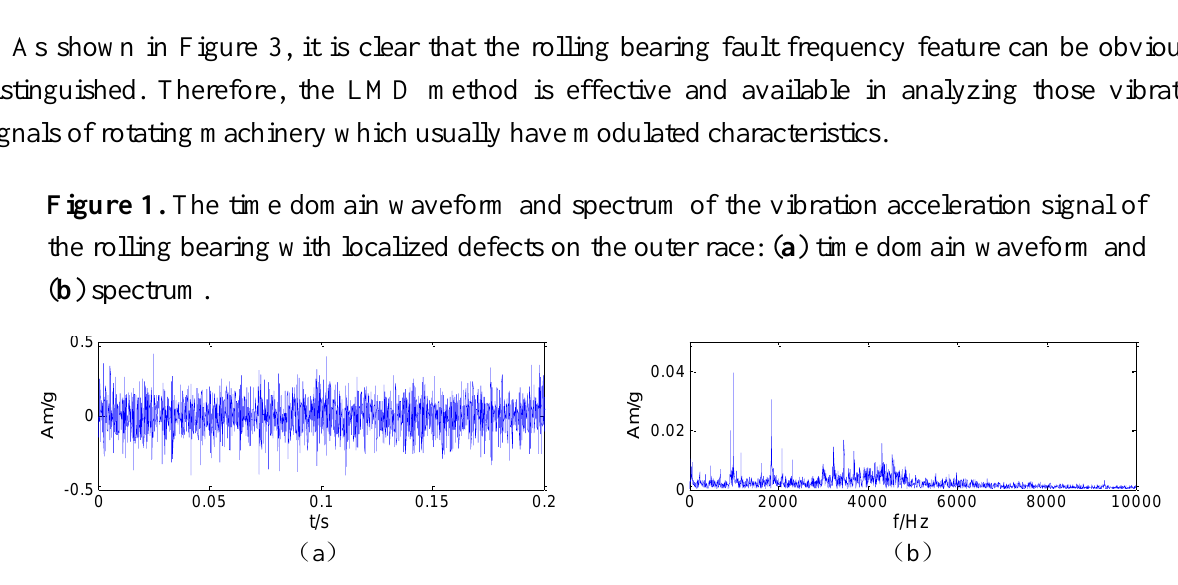
Figure 2. The decomposed results and residue by LMD of a bearing outer race fault signal.